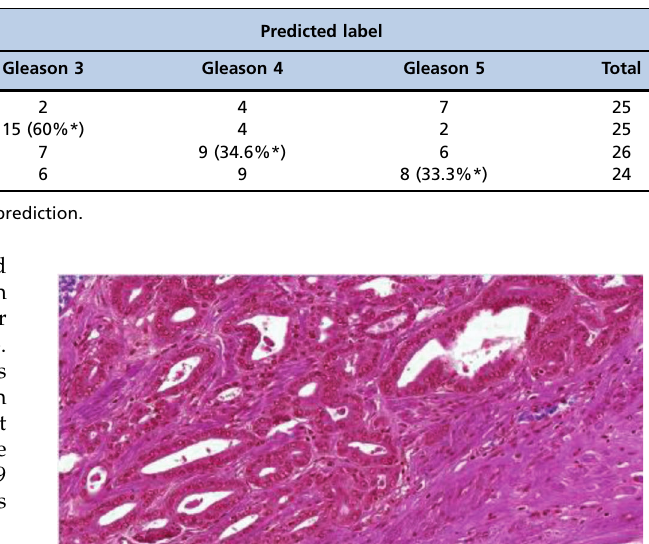
Table 2 - Categorical classification method—true label (pathologist label) versus predicted label (deep learning label) in test dataset images.